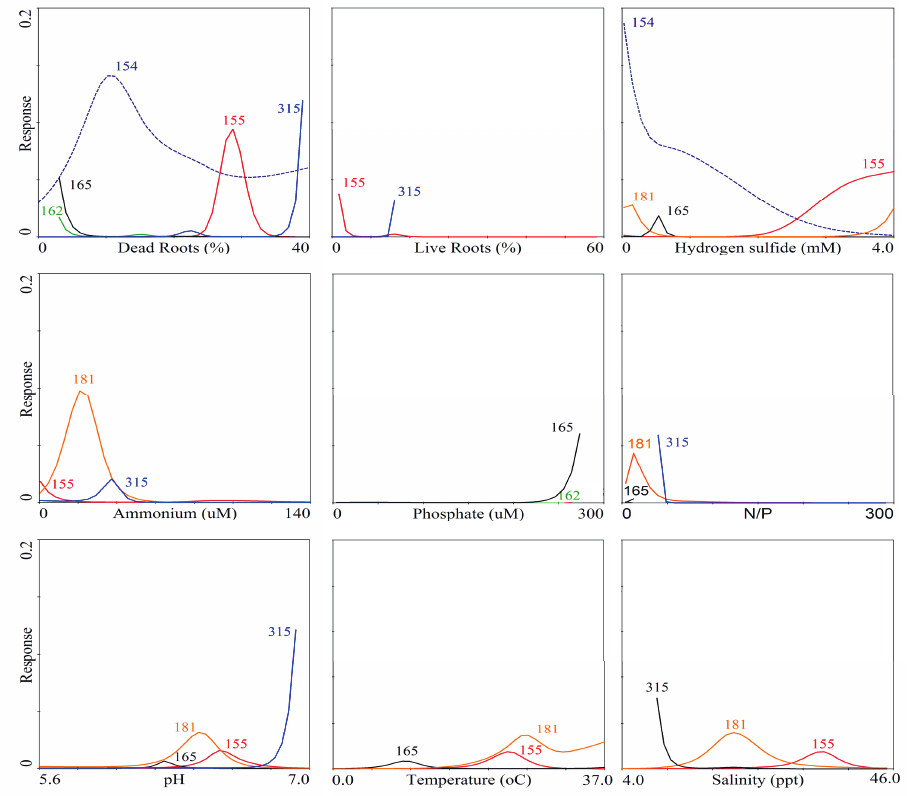
Figure 4. Response curves of seven TRFLP-OTUs to individual environmental parameters, fitted using generalized additive models (GAM) with a Poisson distribution using log link function, df = 3. The graphs summarize the functional relationship of significant non-linear relationships ( p < 0.05) between response variables (TRFLP-OTUs fractional abundance in y -axis) and a covariate term (environmental parameter in x -axis). Each colored curve indicates a different